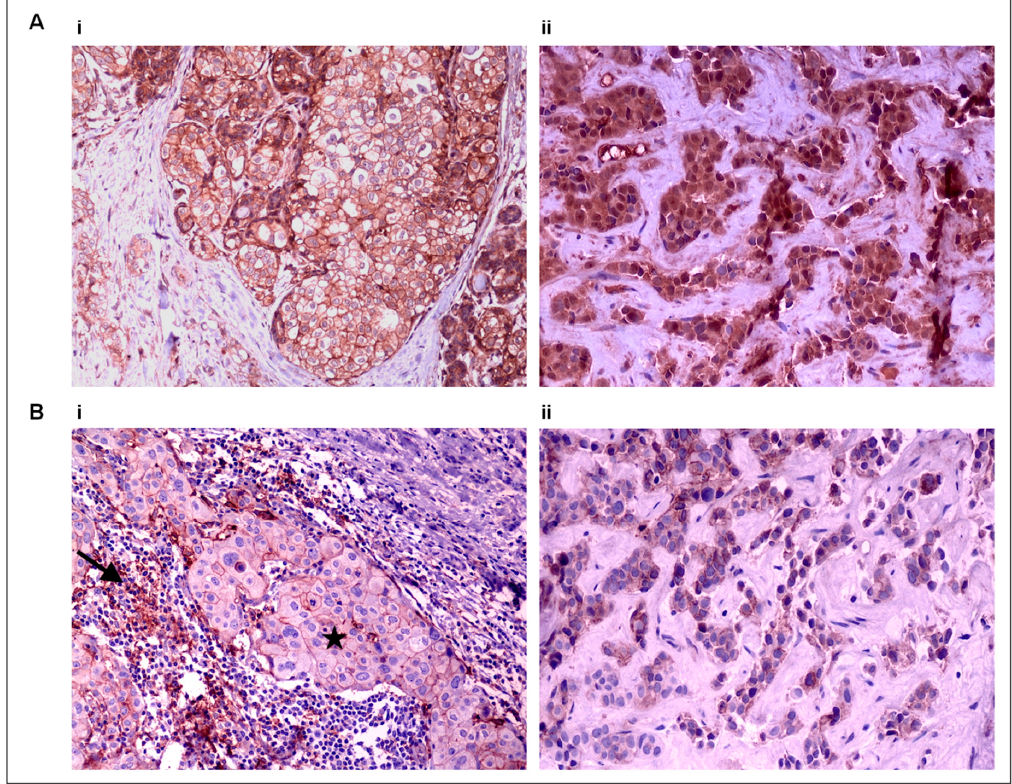
Figure 4. Tissue CD47 and PD-L1 expression by immunohistochemistry (IHC). ( A ) CD47 expression on tumor cells in ( i ) a primary BC tumor (×200) and ( ii ) the corresponding skin metastasis (×400), and ( B ) PD-L1 expression on tumor cells (star) and tumor-infiltrating lymphocytes (TILs) (arrow) in ( i ) a primary BC tumor (×200) and ( ii ) the corresponding liver metastasis (×400). The following comparisons were performed.